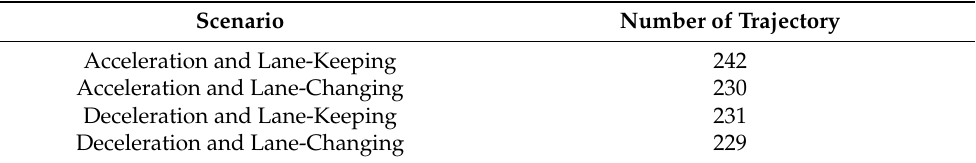
Table 2. Dataset statistics.